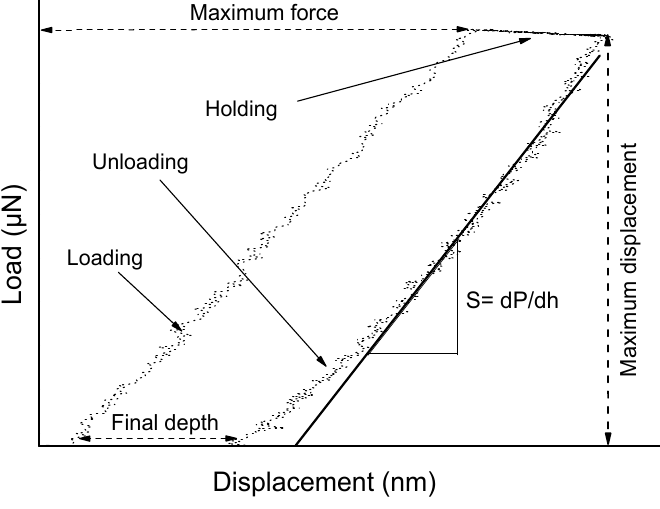
Figure 1. Schematic of the nano-indentation test for hardness and the modulus measurement.